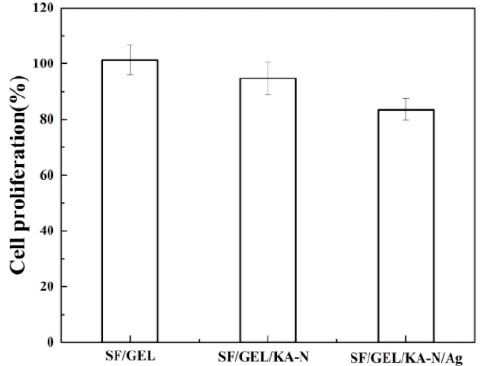
Figure 11. The cytotoxicity test results of silk fi broin/gelatin (SF/GEL), silk fi broin/gelatin/kaolinite nanotubes (SF/GEL/KA-N), and silk fi broin/gelatin/kaolinite nanotubes/silver nanowire (SF/GEL/KA-N/AgNWs). nanotubes (SF/GEL/KA-N), and silk fibroin/gelatin/kaolinite nanotubes/silver nanowire